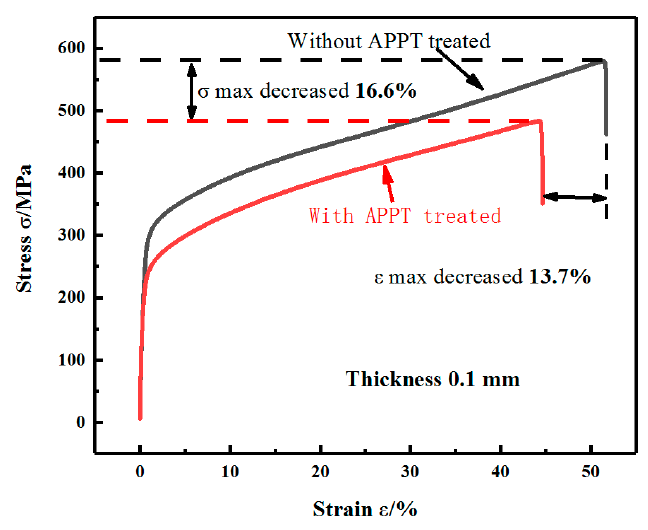
Figure 6. Stress-strain curve of sample with and without APPT.